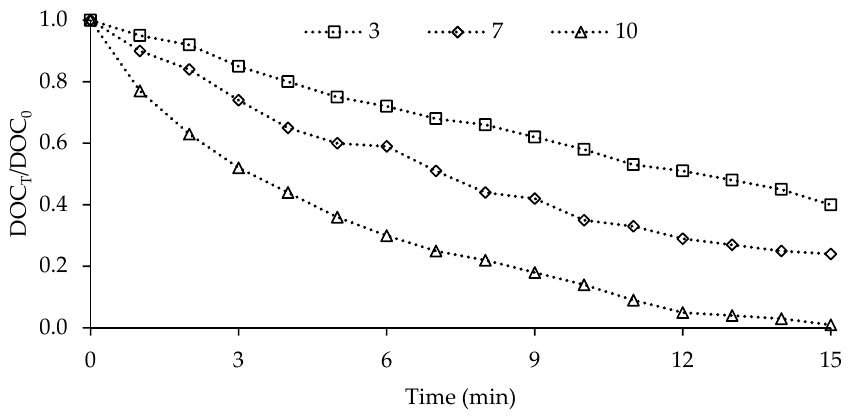
Figure 10. Effect of initial pH values on the performance of catalytic ozonation ([Catalyst] = 0.050 g L − 1 , [O 3 ] = 10 mg L − 1 , [HA] = 10 mg L − 1 , n = 600 rpm).